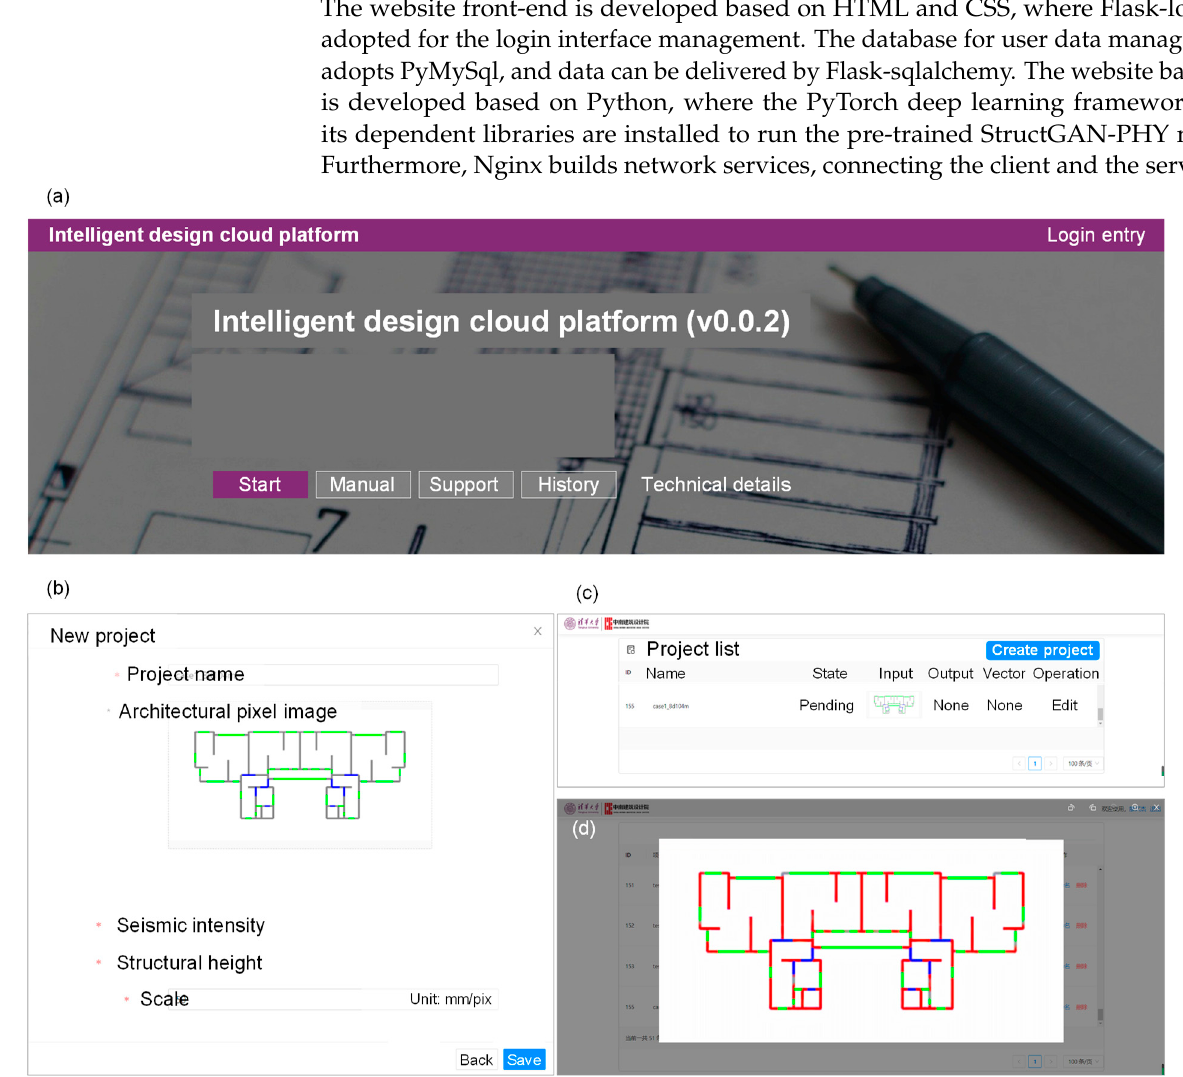
Figure 6. Cloud design platform: ( a ) homepage; ( b ) project creation; ( c ) project list; ( d ) design result. (The user interface of the platform is in Chinese, and the figure is translated into English for convenient reading.)